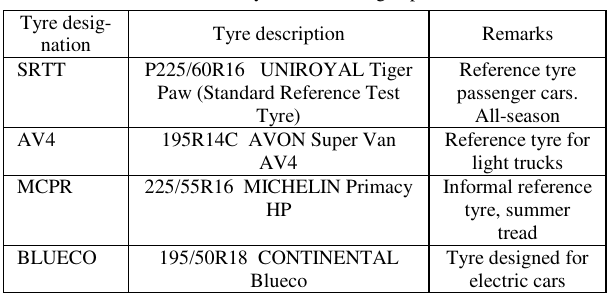
Table 1. List of tyres used during experiments Tyre desig- nation